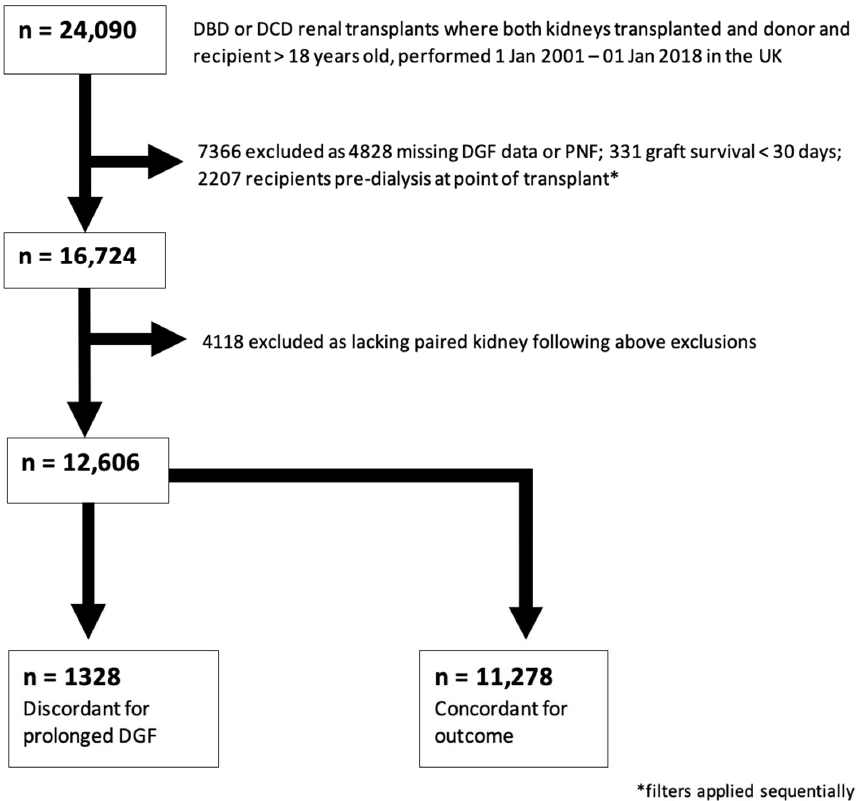
Figure 1. Study Population Selection (prolonged DGF). Consort-type flow diagram showing selection of the case-control cohort for analysis 1 (prolonged DGF). 1328 outcome-discordant transplants were identified for inclusion in this study.